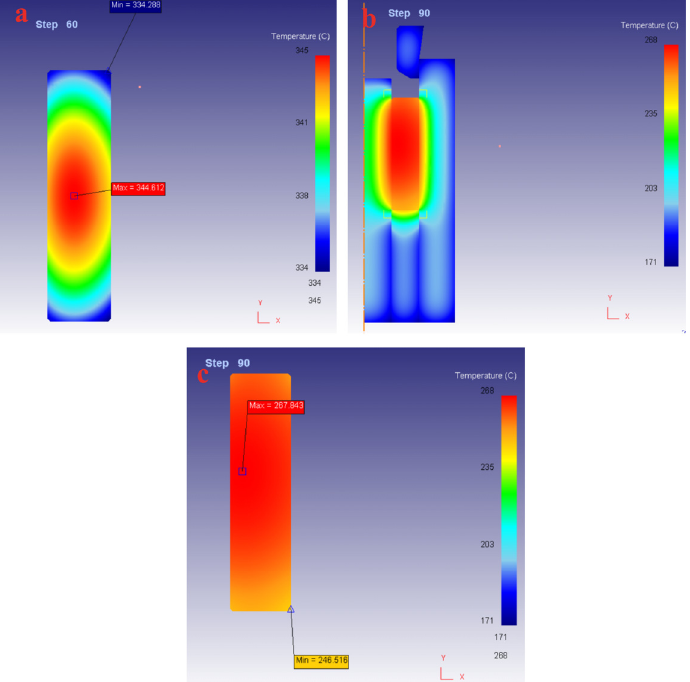
Figure 9. Thermal analysis diagram of 2A12 aluminum alloy tube extrusion process. ( a ) Blank temperature after 60 s air cooling; ( b ) Temperature after 30 s die heat transfer; ( c ) Billet temperature after 30 s die heat transfer.